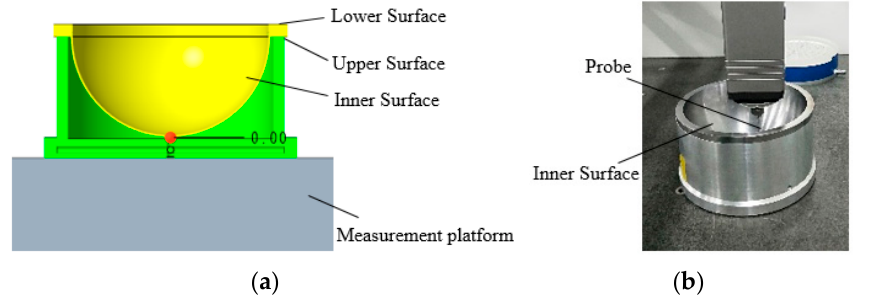
Figure 9. The inner surface measurement: ( a ) the measurement model; ( b ) measuring the real ob ‐ ject.